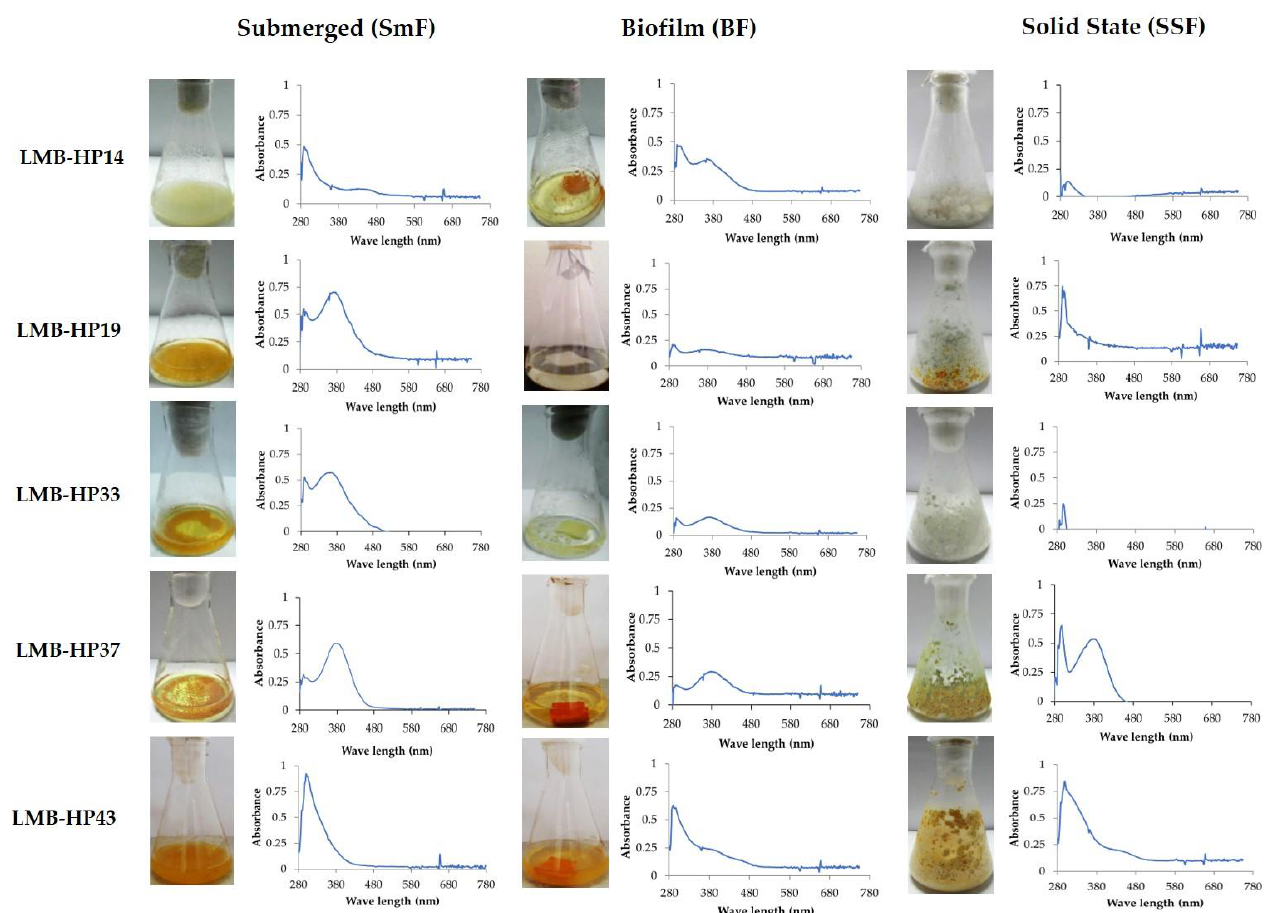
Figure 3. Absorption spectra at UV and visible regions of extracellular pigments of T. wortmannii LMB-HP14, P. mallochii LMB-HP19, P. maximae LMB-HP33, P. mallochii LMB-HP37, and T. brunneus